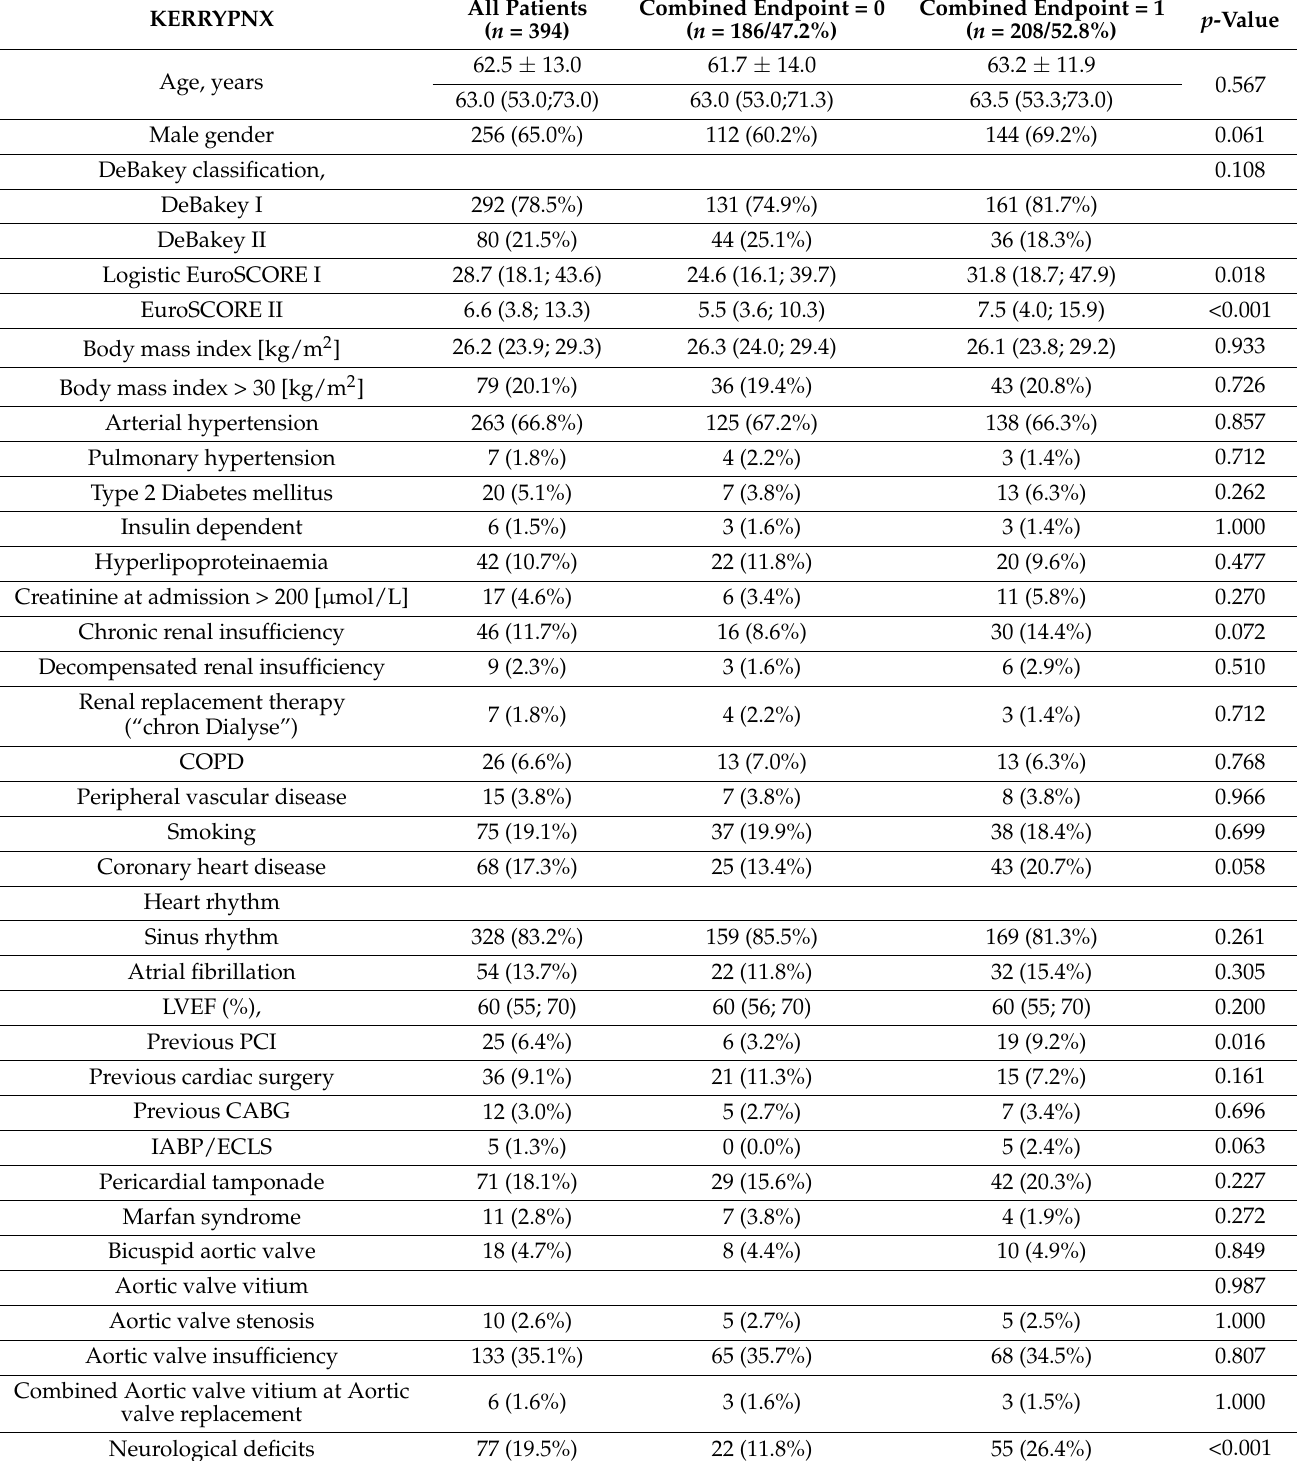
Table 1. Demographic and clinical characteristics of the study